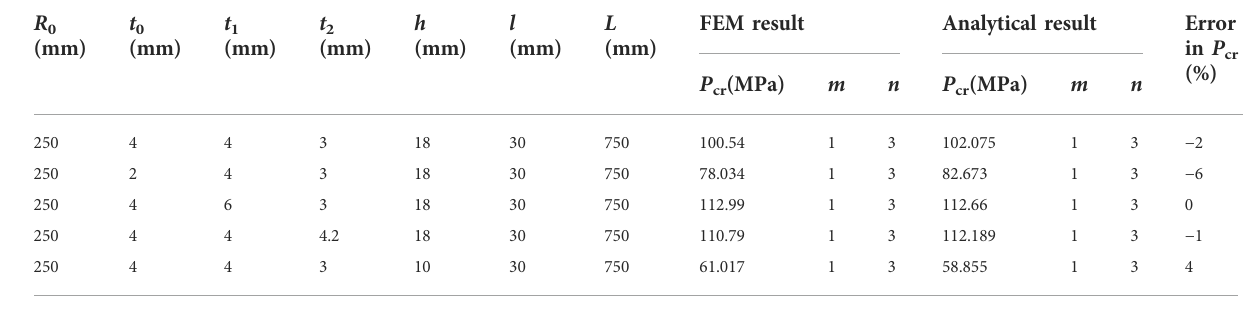
TABLE 3 Comparison of buckling analysis results for steel